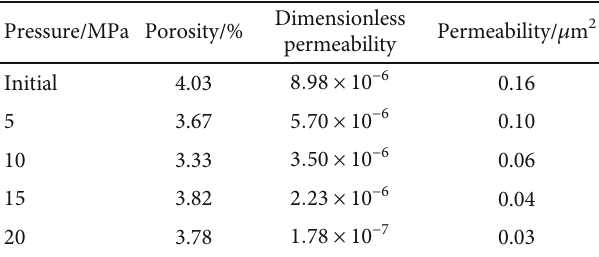
Figure 8: The images of streamlines in the fractured-vuggy sample. Table 3: LBM-simulated permeability data for fractured-vuggy